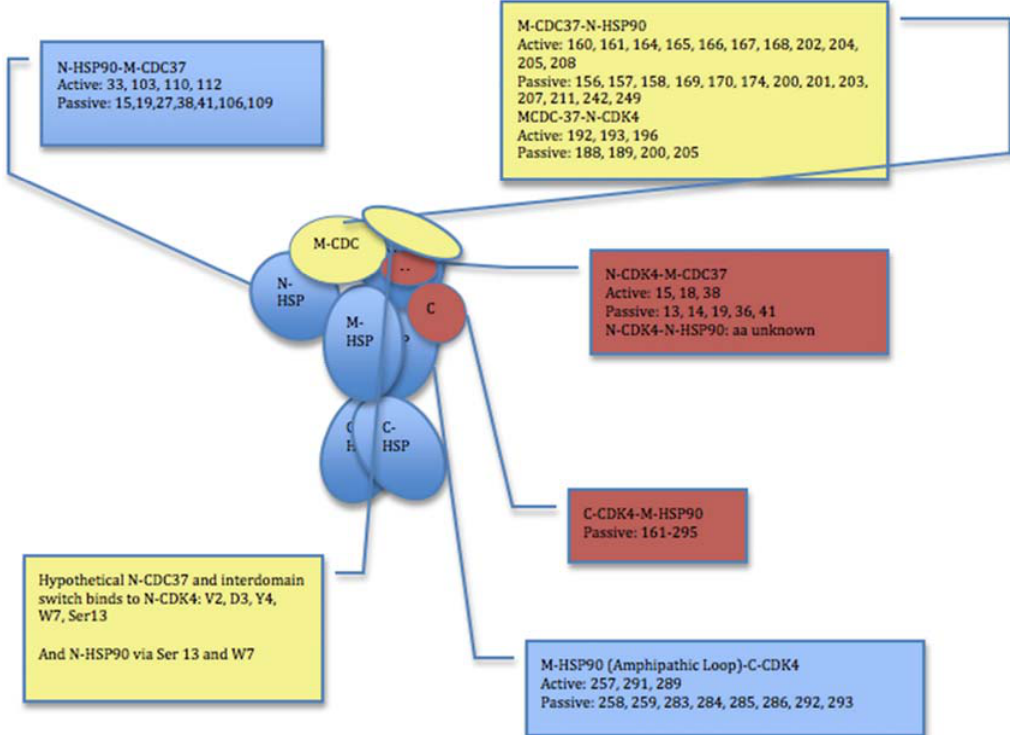
Figure 4. A Schematic Map of Experimentally-Guided Interaction in HADDOCK Simulations. The cartoon outlines and summarizes the selections of active/passive residues and experimental restraints for HADDOCK simulations. Definition of active residues was derived driven from EM reconstruction data of the Hsp90-Cdc37-Cdk4 [53] and mutagenesis studies of chaperones and kinase clients [60–74]. A combination of experimental restraints and bioinformatics-based analysis of binding interfaces was used to determine sets of active and passive residues for